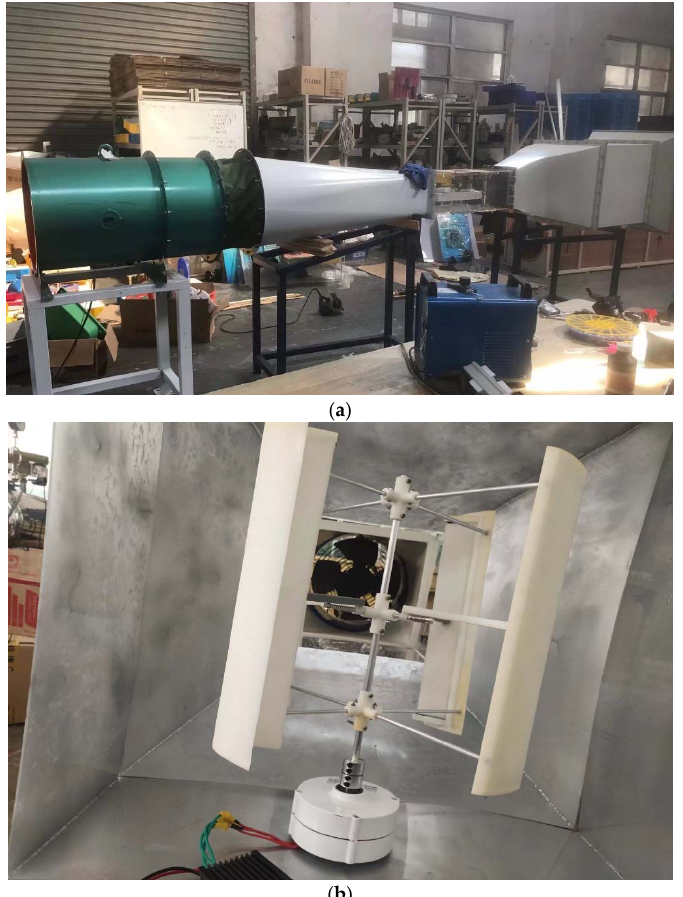
Figure 11. DC type low speed jet wind tunnel: ( a ) exterior view of wind tunnel, ( b ) interior view of wind tunnel. An anemometer was used in the experiment to monitor wind power, as shown in Figure 12. The model of the anemometer is a “DP3000”, equipped with a 300 mm ‐ long